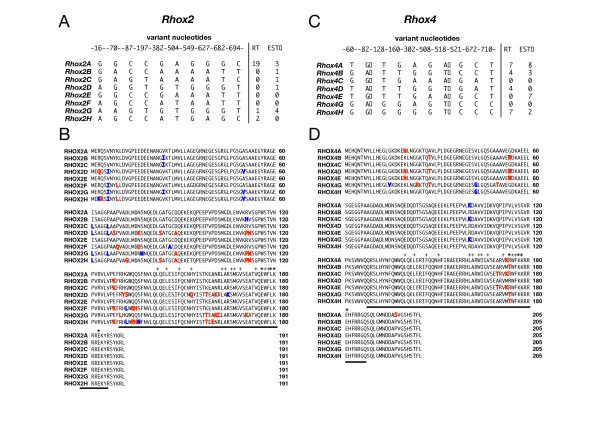
A & C. Unique nucleotide profile and relative expression of the predicted Rhox2A-H (A) or Rhox4A-H (C) transcripts. The position of the nucleotides is relative to the published start sites. Column RT and EST refers to the number of each transcript detected by RT-PCR or in the EST database respectively that matched this profile. B & D. ClustalW alignment of predicted amino acid sequence from Rhox2A-H (B) or Rhox4A-H (D) Residues different from the consensus are highlighted in blue (conservative amino acid change) or red (non-conservative amino acid change). The homeobox domain is underlined with hydrophobic residues (+) crucial for homeodomain packing and residues involved in DNA binding (*) annotated.